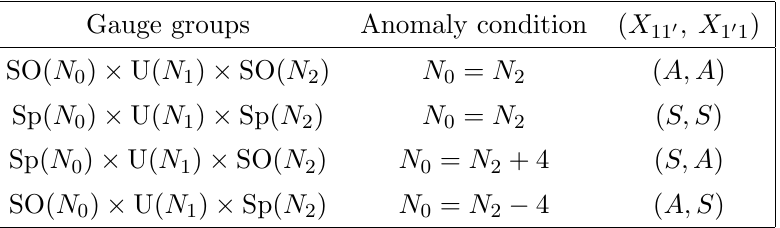
Table 10. The various orientifold projections (cid:10) of C 3 = Z 4 . \A" stands for \Antisymmetric repre- sentation", while \S" for \Symmetric